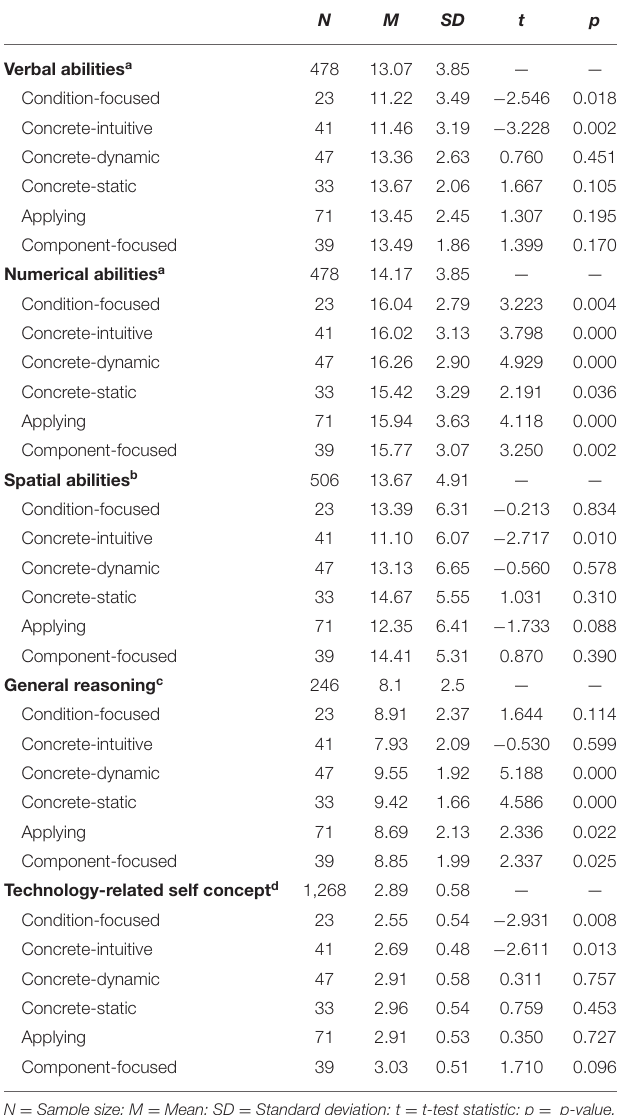
TABLE 5 | Values and one-sample t -tests against reported means from comparable reference groups abcd of the cognitive and affective scales for each ontological profile used in Figure 1